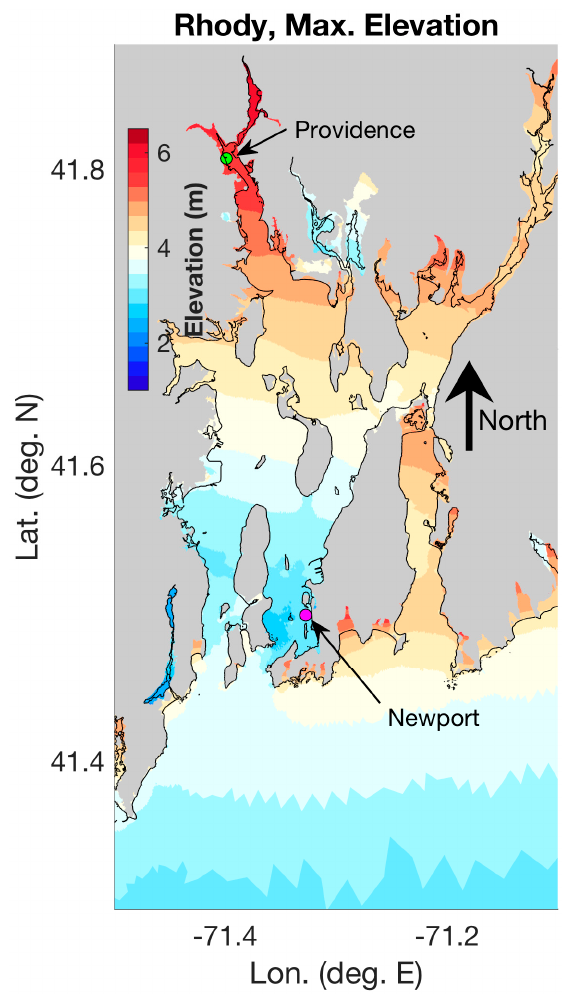
Figure 8. Simulated (ADCIRC / SWAN) maximum surface elevation for the synthetic storm Hurricane Rhody in the Narragansett Bay region on a mesh that does not include the FPHB and without river inflows. The black line represents the coastline, and colored areas shoreward of the coastline represent areas experiencing overland flooding. The green and the magenta circles denote, respectively, the locations of the Providence and the Newport tide gauges.